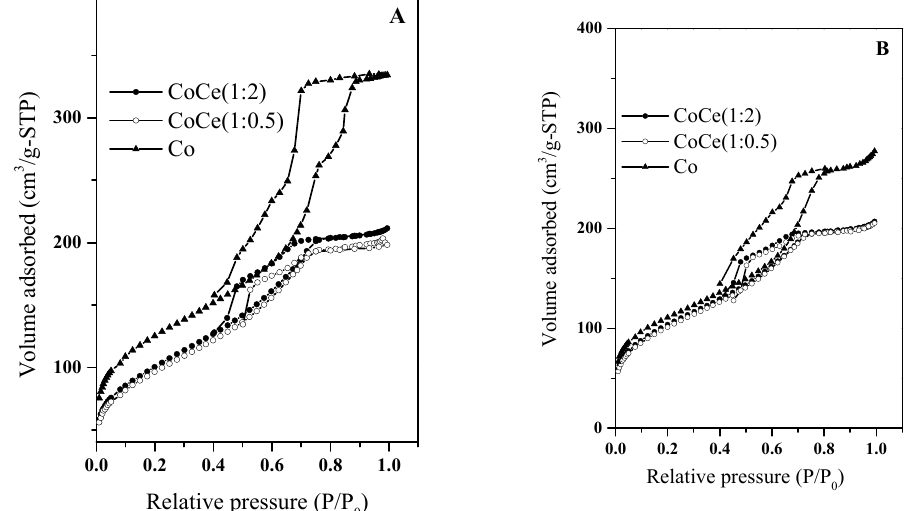
Figure 2. Nitrogen adsorption–desorption isotherms of the catalysts before ( A ) and after ( B ) n -hexane oxidation. Table 1. D-spacing values, specific surface area (S BET ), micropore surface area (S µ ), total pore vol- ume (V p ), micropore volume V µ , mesopore volume V mes , and pore diameter ( ∅ ) of the catalysts before (BR) and after (AR) reaction (n-hexane oxidation).